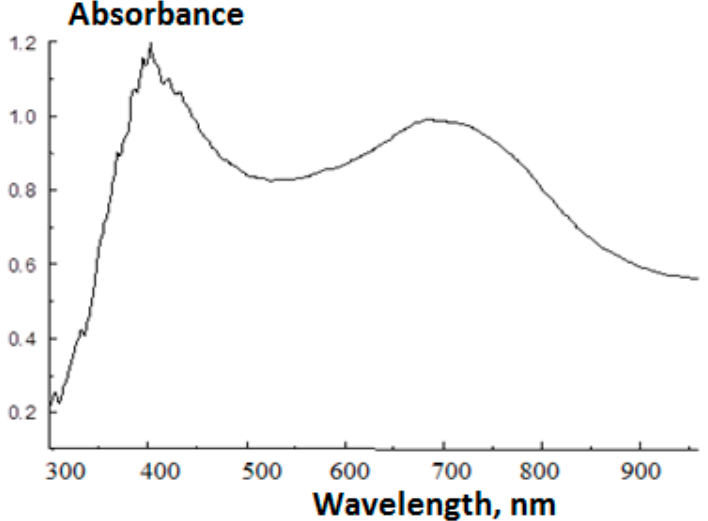
Figure 14. Optical spectra for the sample of the hybrid metal–mesogenic nanosystem Ag / 4-cyano-4 (cid:48) -pentylbiphenyl (1:10 w / w%) encapsulated in poly-para-xylylene